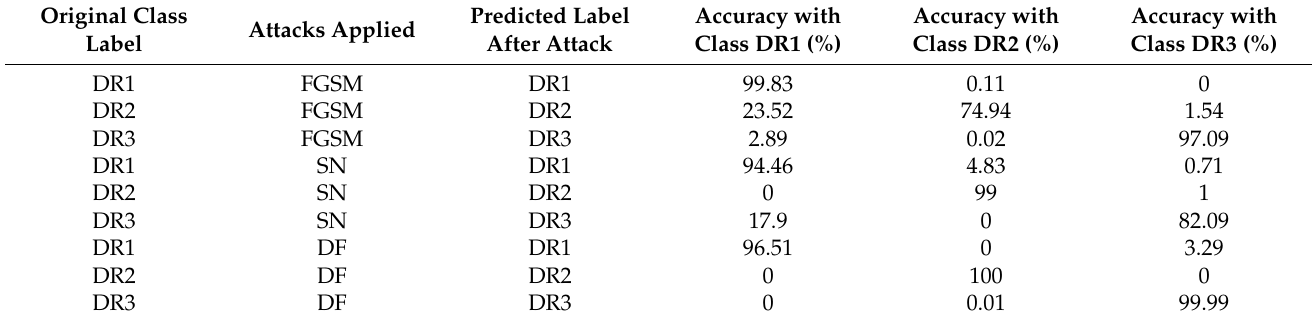
Table 6. Testing of Mixed Adversarial Training MAT Network with Attack